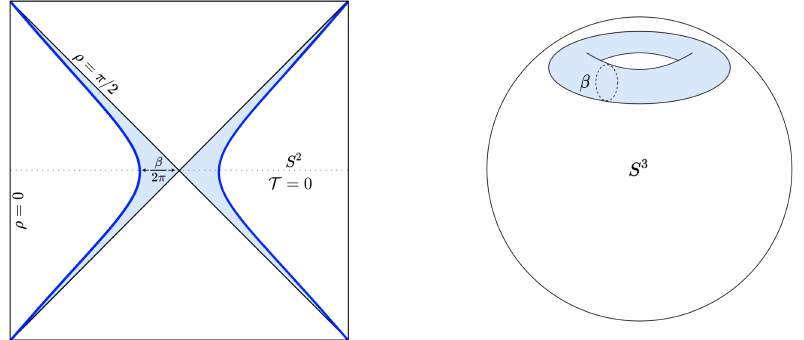
Figure 3 . The Penrose diagram on the left shows the Lorentzian picture of the edge modes, which live on the thick, blue line at a distance β/ 2 π (cid:28) ‘ from the horizon. On the right is the Euclidean picture, where the edge modes live on the surface of a solid torus with thermal cycle β . Shrinking the thermal cycle is the same as taking the high temperature limit, ot taking the edge modes to live very close to the